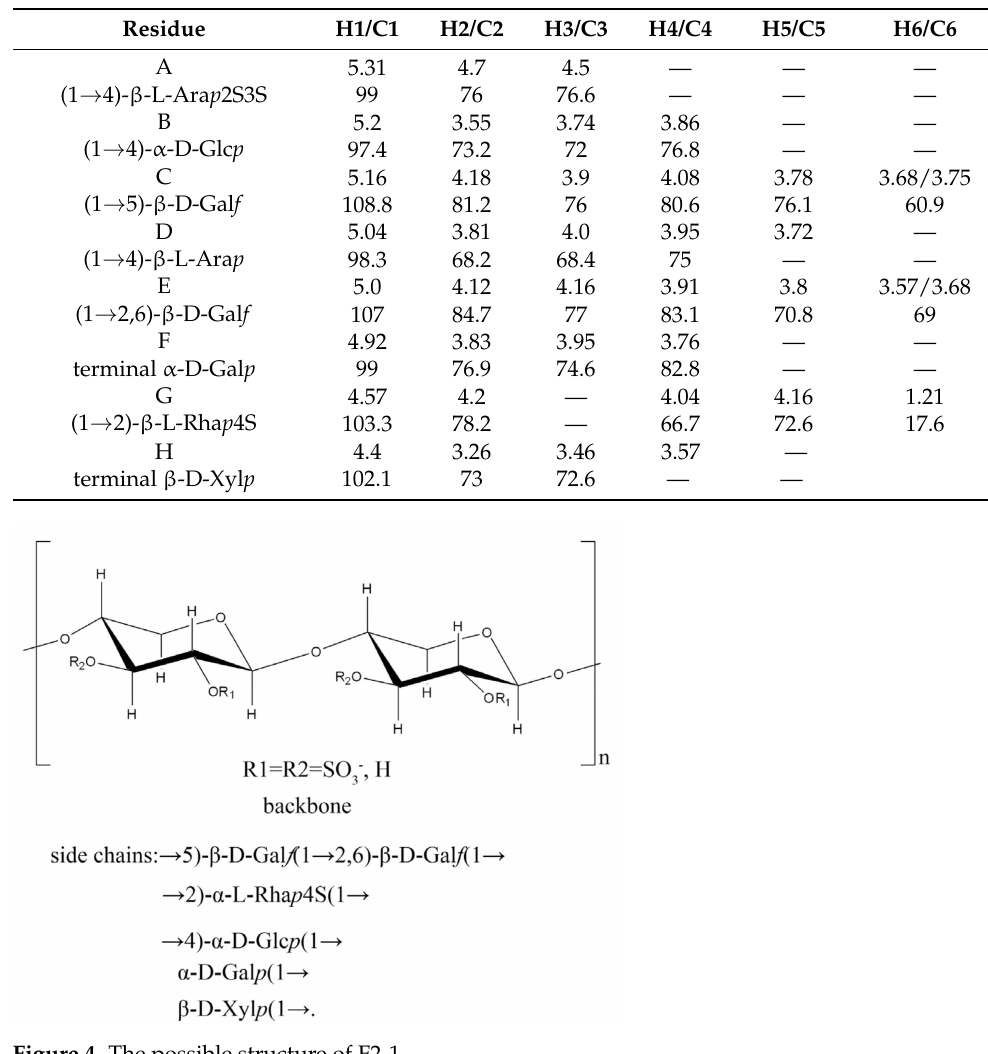
Table 2. The 1 H and 13 C NMR chemical shifts ( δ ) for the residues of F2-1. Residue